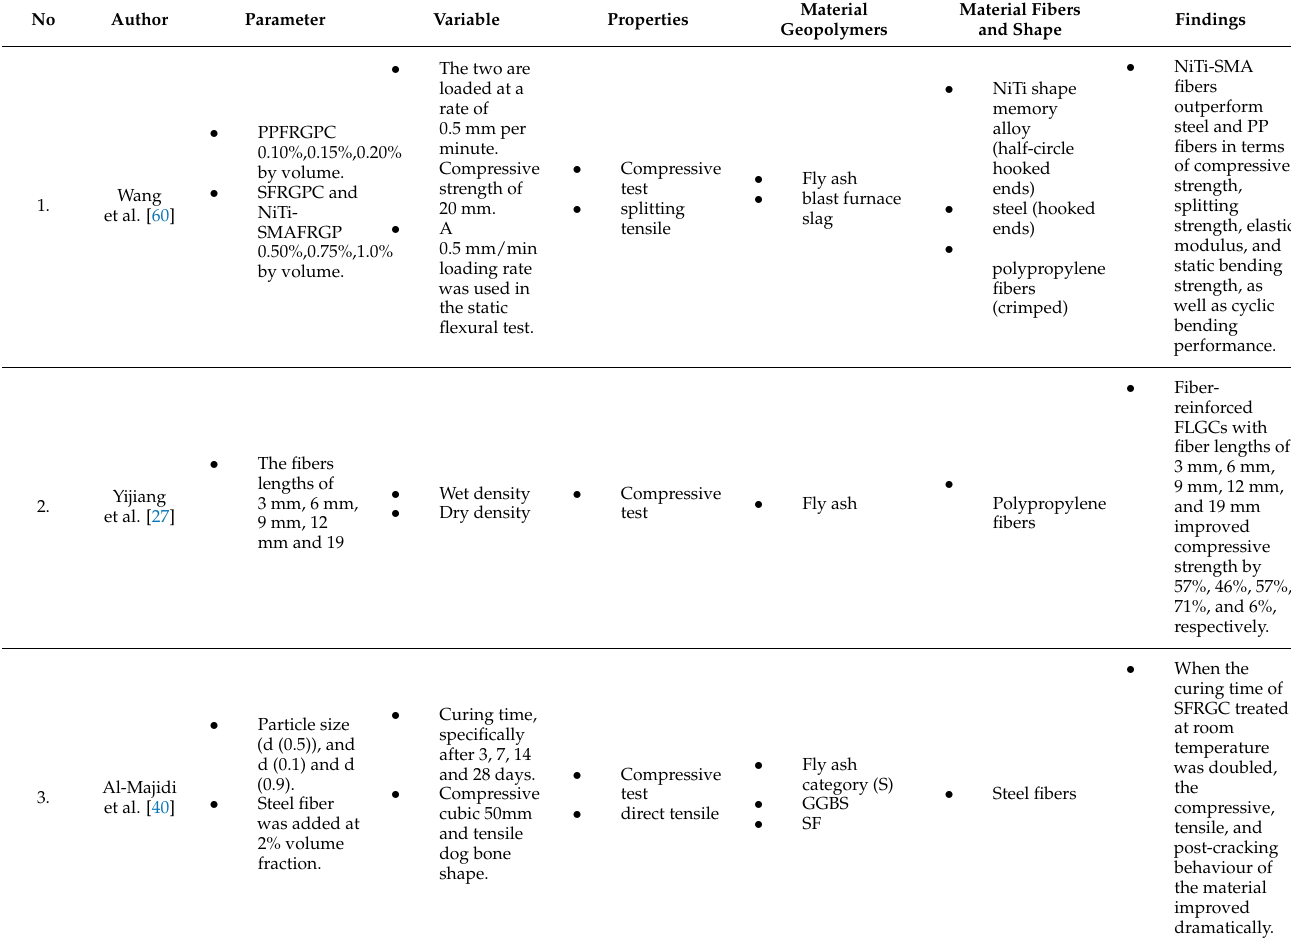
Table 1. Research on geopolymers concrete reinforced